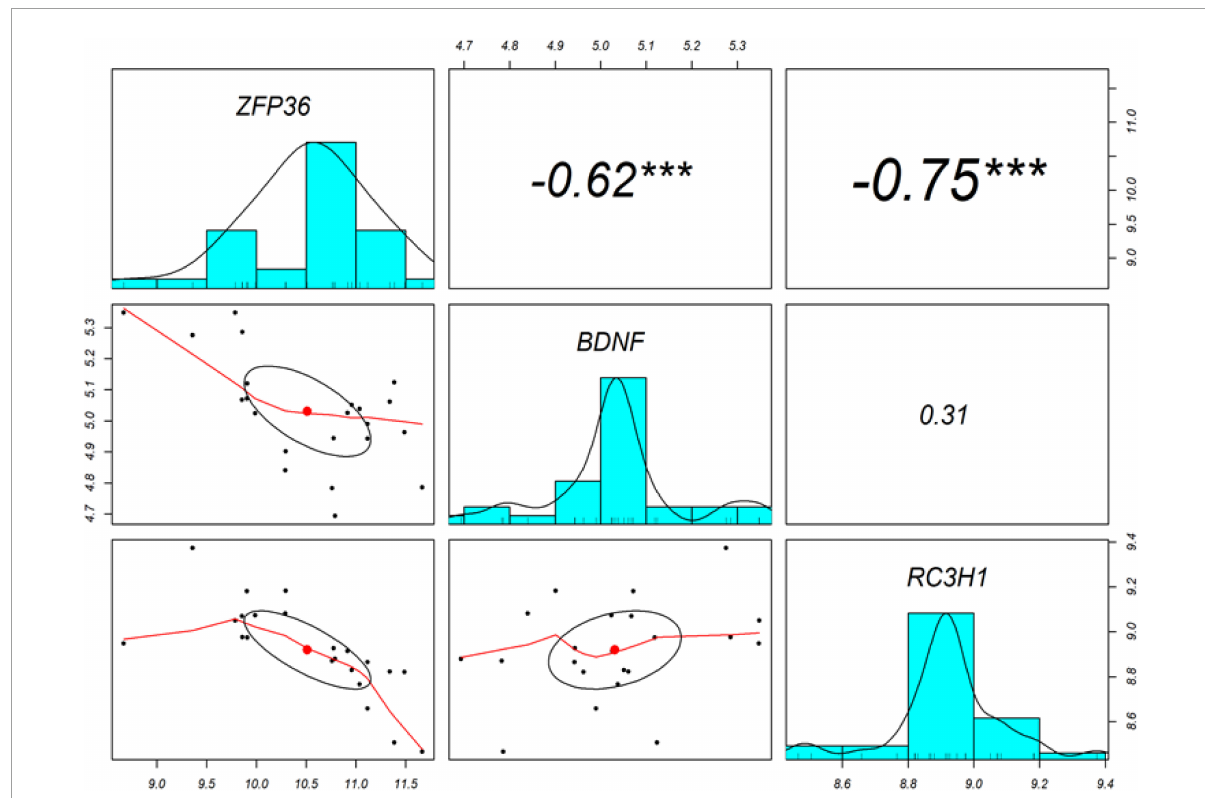
FIGURE4 The diagonal depicts the distribution of each variable. The bottom section of the diagonal depicts bivariate scatter plots with a fitted line. The correlation coefficients and significance level are presented as stars on the top section of the diagonal. ***Indicates a significant association with a p -value < 0.001.